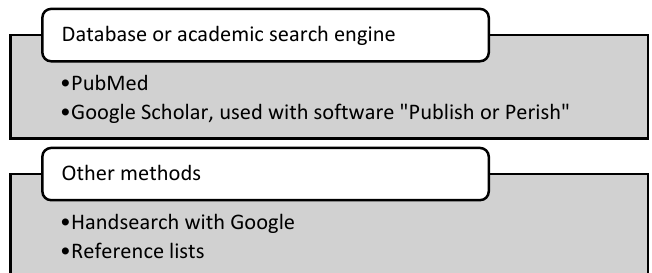
Figure 1. Search Figure 1. Search strategies.